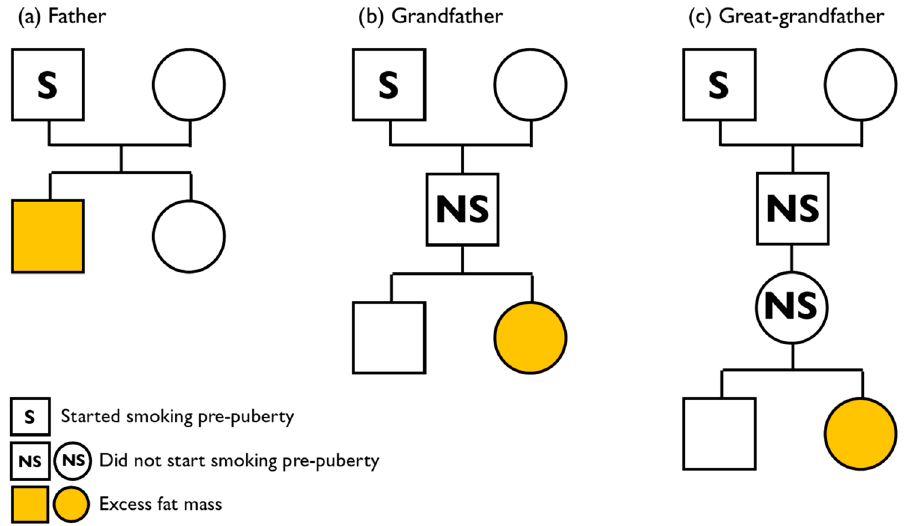
Figure 2. The way in which the onset of smoking pre-puberty is associated with extra fat mass in the subsequent family: ( a ) the father who starts smoking pre-puberty is associated with excess fat mass in his sons; ( b ) the paternal grandfather who starts smoking pre-puberty is associated with excess fat mass in his granddaughters; ( c ) the maternal grandfather’s father who starts smoking pre-puberty is associated with excess fat mass in his